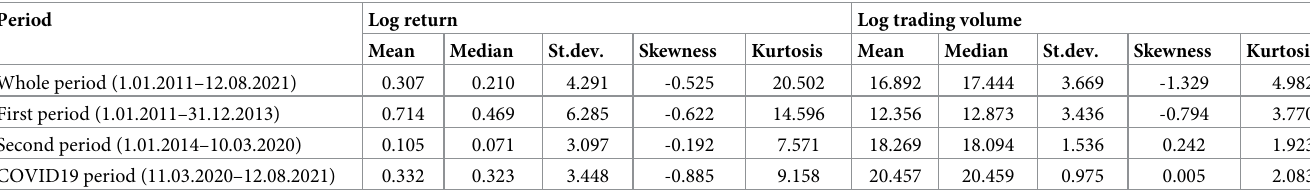
Table 1. Summary statistics for Bitcoin daily returns and log trading volume.